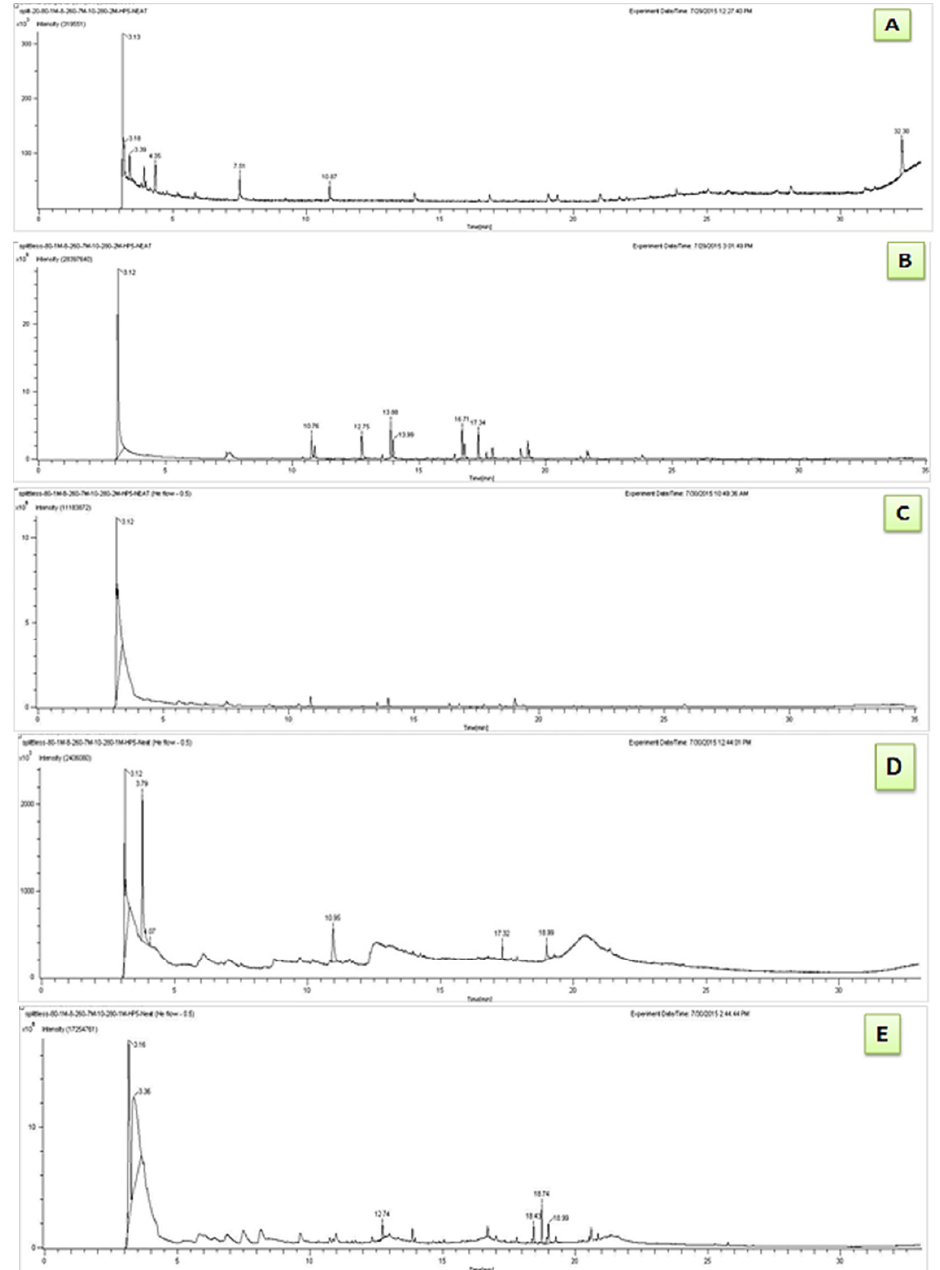
Figure 3. Gas Chromatography-Mass Spectrometry (GC-MS) chromatograms of A) petroleum ether B) chloroform C) acetone D) ethanol E) methanol leaves